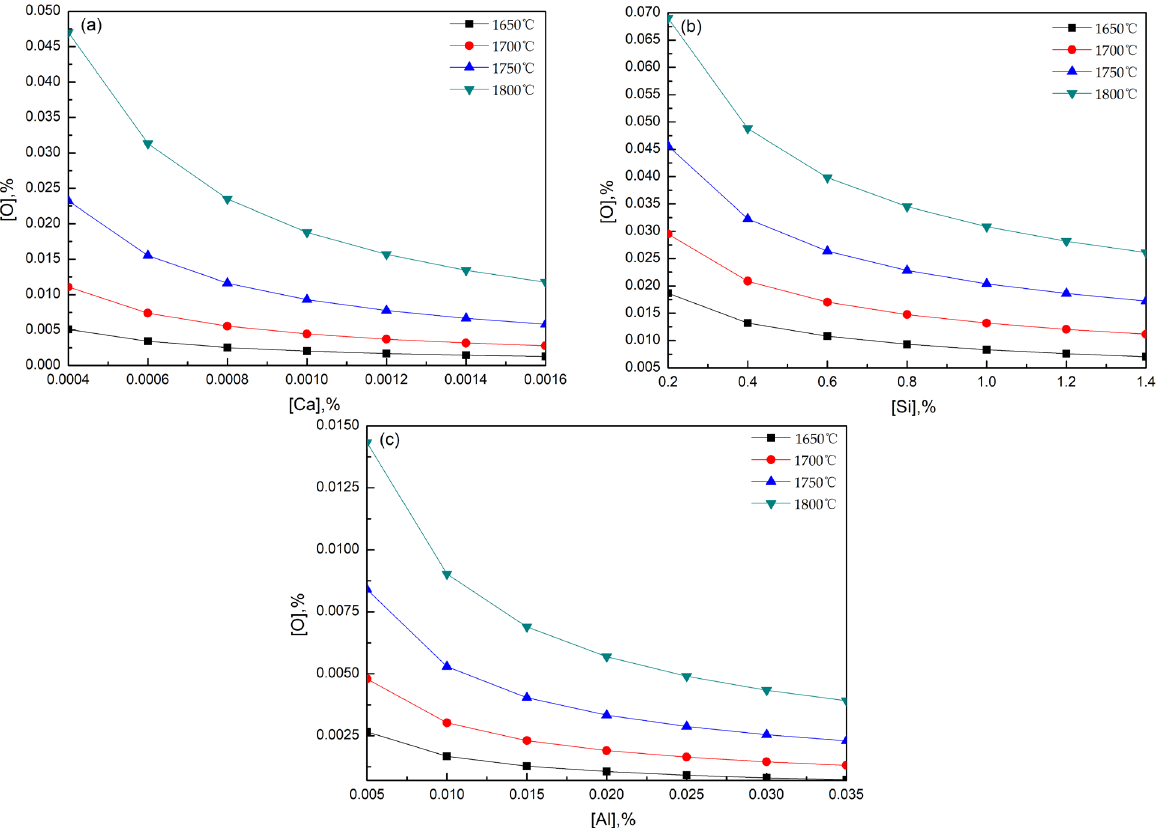
Figure 13. Equilibrium diagram of elements and oxygen in molten steel at different temperatures: ( a ) [Ca]-[O] reaction, ( b ) [Si]-[O] reaction, ( c ) [Al]-[O] reaction.